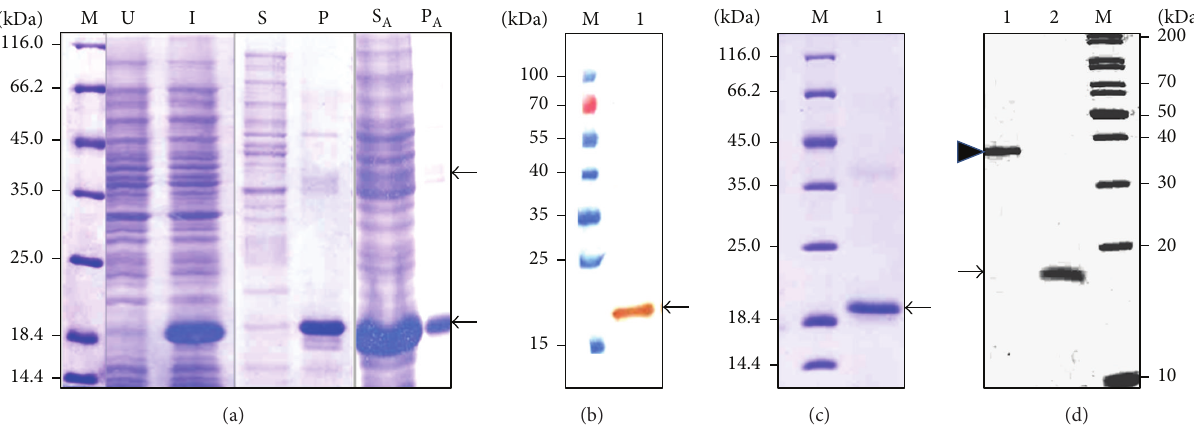
Figure 1: Analysis of expression of recombinant IL-10 of L. rohita . (a) E. coli BL21 ( 𝜆 DE3) cells harboring pET Lr IL-10 were induced with IPTG. Lanes “U” and “I” represent total cell lysates of uninduced and induced cells, respectively. Lanes S and P represent the soluble and pellet fractions, respectively, of the induced cell lysate prepared in 10 mM Tris-HCl, pH 7.0. Lanes S A and P A represent the soluble and insoluble fractions, respectively, of the induced cells lysed in 10mM Tris-HCl, pH 7.0, containing 0.5 M arginine. (b) Western blot analysis of induced cell lysate prepared in the presence of 0.5 M arginine (lane 1) using anti-His antibody. (c) SDS-PAGE (12%) analysis of purified r Lr IL-10 (lane 1). Arrow in Panels (a)–(c) points to r Lr IL-10. (d) Analysis of oligomeric state of r Lr IL-10. SDS-PAGE analysis of the unboiled (lane 1) and boiled r Lr IL-10 (lane 2), prepared in nonreducing and reducing conditions, respectively. The arrow head and arrow point to the dimeric and monomeric forms of the r Lr IL-10 in unboiled and boiled samples, respectively. M in all the panels indicates protein molecular weight